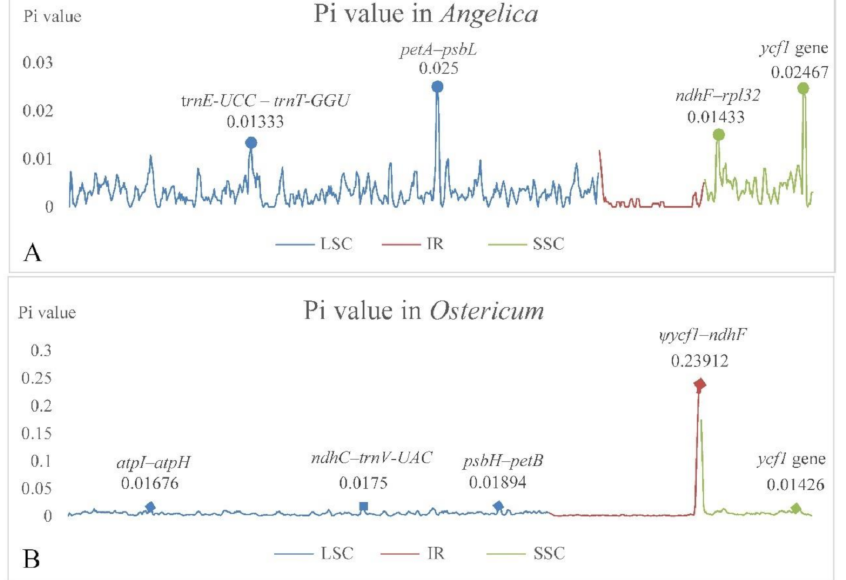
Figure 6. The nucleotide diversity of ( A ) five Angelica species and ( B ) nine Ostericum species. The regions with higher Pi values are marked. LSC (large single-copy), SSC (small single-copy), and IR (inverted repeat)